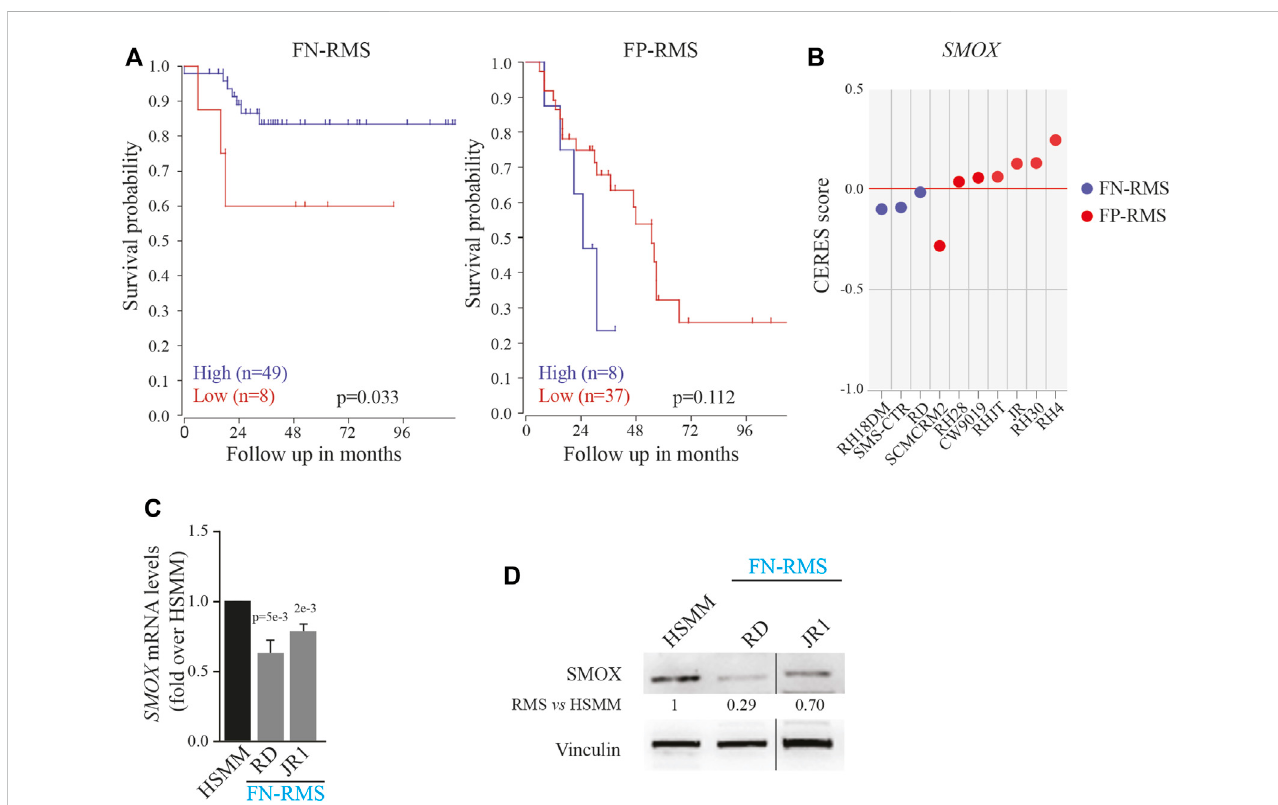
FIGURE 1 Impact ofSMOX expressionon RMSpatients and cell lines. (A) Correlation between SMOX expression level [Williamson dataset (E-TABM-1202)]and FN- ( n = 57) and FP-RMS ( n = 45) patients ’ survival. (B) Effects of SMOX depletion on RMS cancer cell lines obtained by DepMap (www.depmap.org). (C) SMOX mRNA levels (qRT- PCR) in RD and JR1 FN-RMS cell lines and in normal Human Skeletal Muscle Myoblasts (HSMM) were normalized to GAPDH levels and expressed as fold increase over HSMM values. Graph represents the mean of three independent experiments ±SD, Student two-tailed t -Test. Exact p -valuesarereportedinthe fi gure. (D) RepresentativewesternblotdepictingSMOXproteinlevelsinwhole-celllysatesfromRDandJR1FN-RMScelllinesand HSMM. Vinculin levels have been used as loading control. HSMM cells have been used as control. Vertical line indicates a cropped